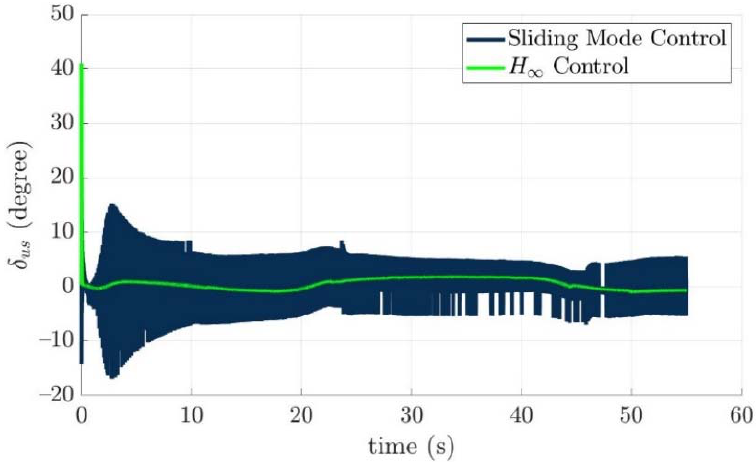
Figure 23. The upward stern rudder angles of the controlled torpedo-like underwater vehicle for two control laws, respectively.